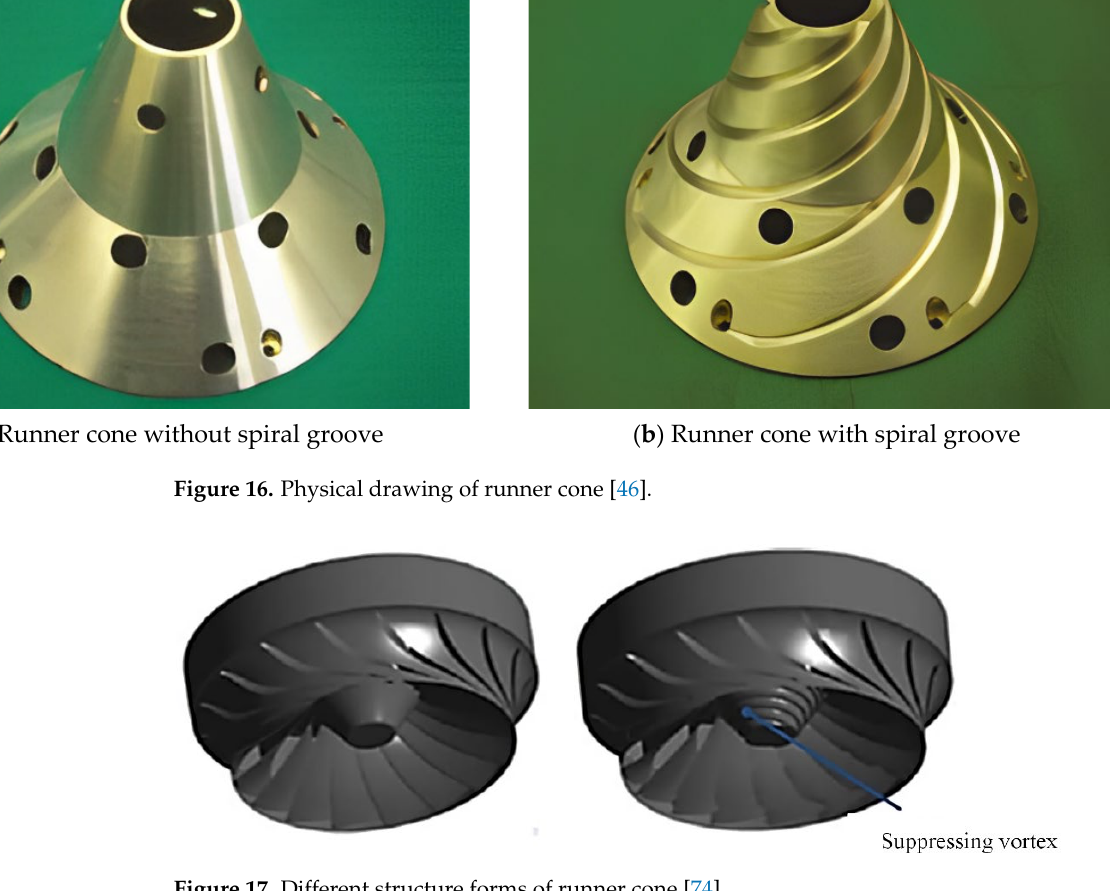
Figure 17. Different structure forms of runner cone [74].